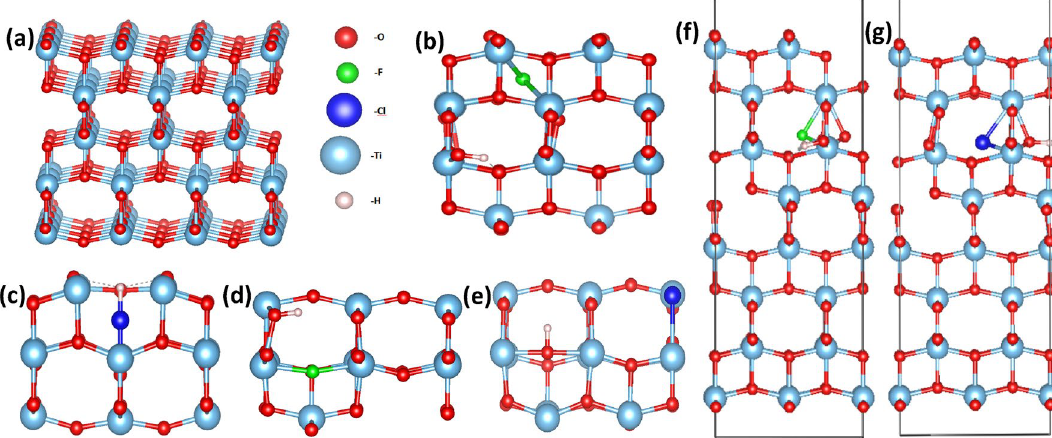
Figure 1. The structures of ( a ) plain TiO 2 supercell, ( b ) F i :H i :TiO 2 , ( c ) Cl i :H i :TiO 2 , ( d ) F o :H i :TiO 2 and ( e ) Cl o :Hi:TiO 2 . The surface structure of ( f ) F i :H i :TiO 2 and ( g ) Cl i :H i :TiO